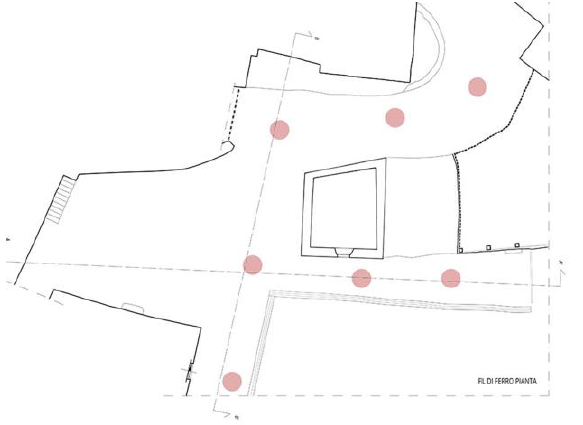
Figure 2. Planimetric survey of the project intervention area.